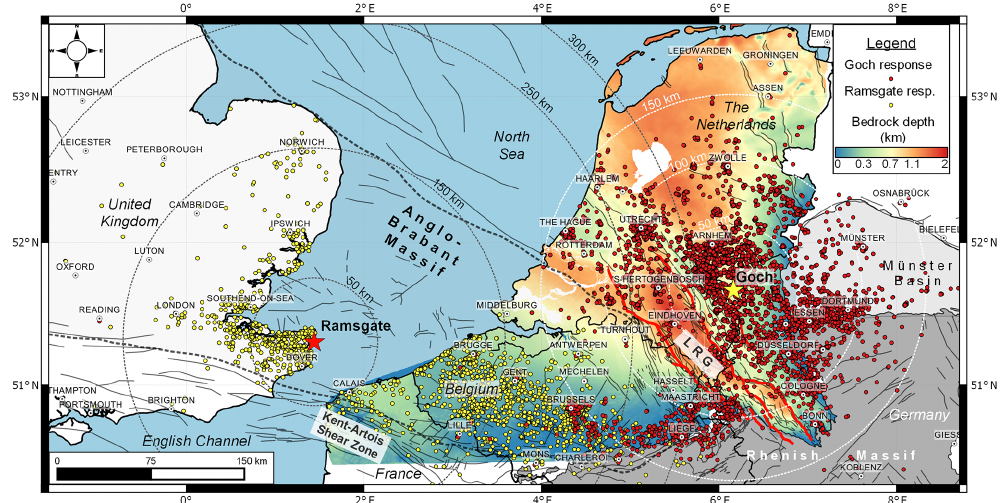
Figure 12. Combined felt distributions of the 2011 Goch earthquake (red) and 2015 Ramsgate earthquake (yellow) illustrated on a depth to bedrock map of northern Belgium, the Netherlands and western Germany. Note the absence of felt responses in northeast Belgium (between Antwerp and Hasselt), southwest of Eindhoven (NL) and southwest of Cologne due to the thick sedimentary cover. Map compiled from numerical data of the Databank Ondergrond Vlaanderen (2016; Belgian Data) and DINOloket (2016; Dutch data) combined with maps of Legrand (1968), Weber (2007), and Hager and Prüfert (1988). Bedrock depth in the UK is not